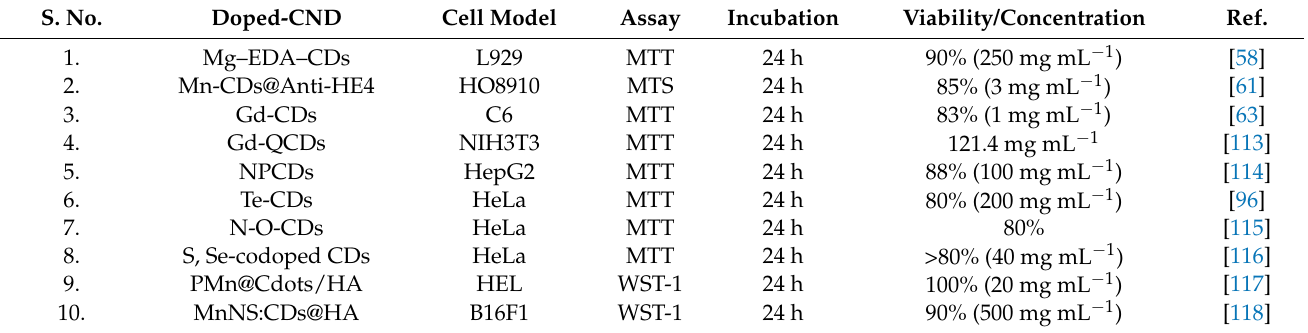
Table 2. Biocompatibility of doped